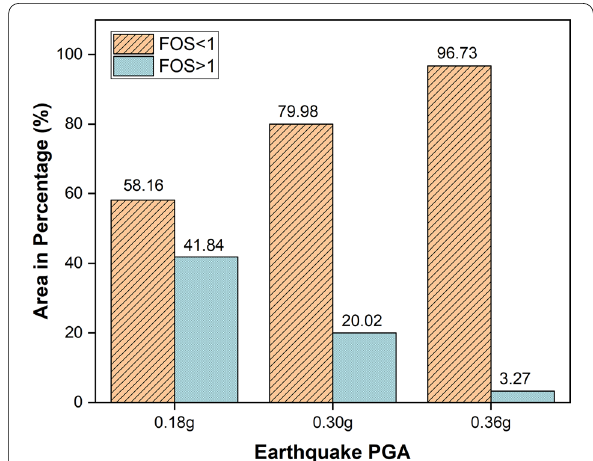
Fig. 10 Area in percentage of FOS against liquefaction in three scenario earthquakes of M w 7.8 (0.18 g), M w 8.0 (0.30 g), and M w 8.4 (0.36 g)